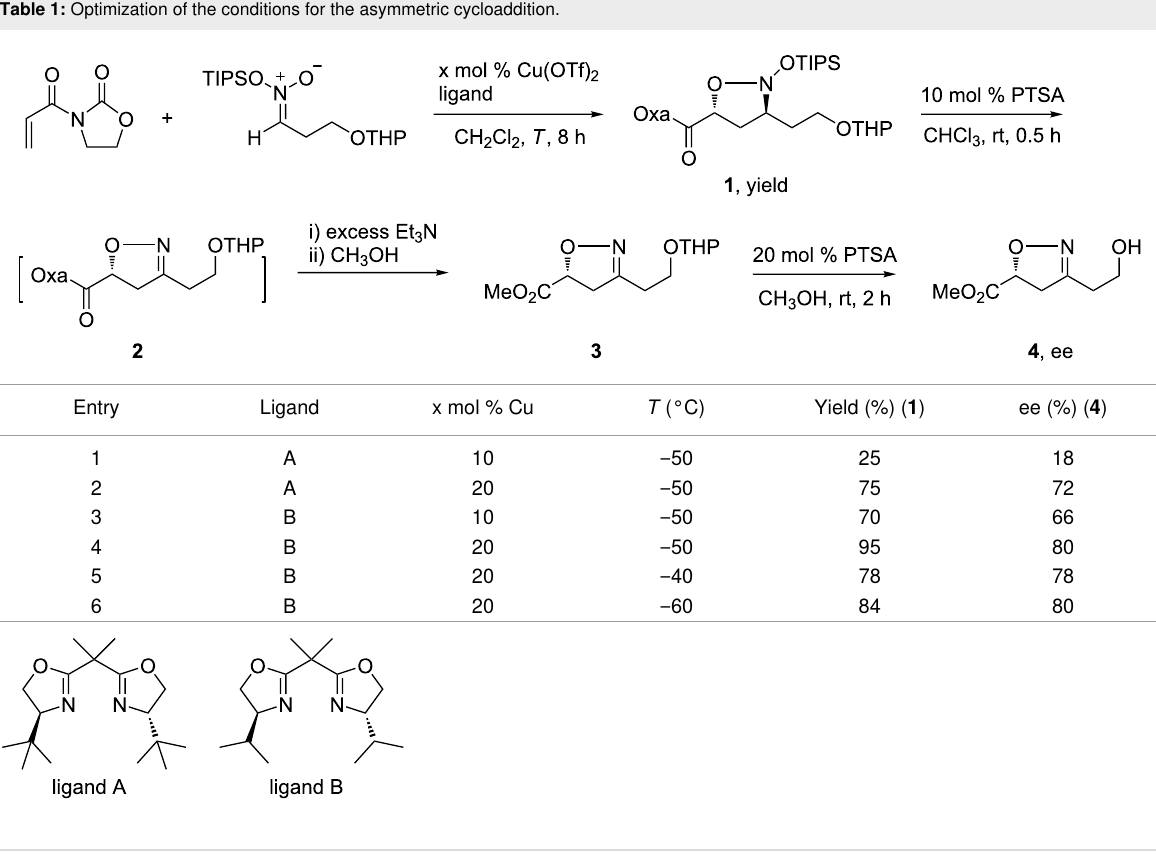
Table 1: Optimization of the conditions for the asymmetric